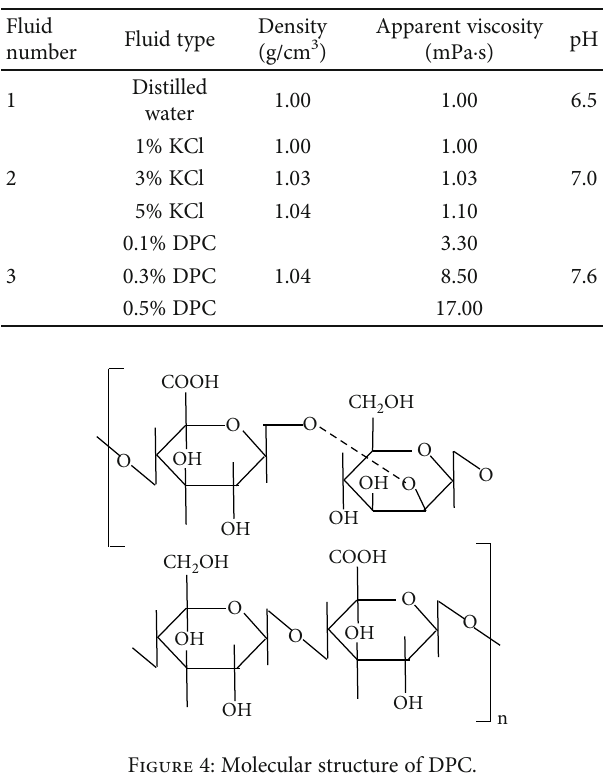
Table 3: Basic features of the working fl uids.